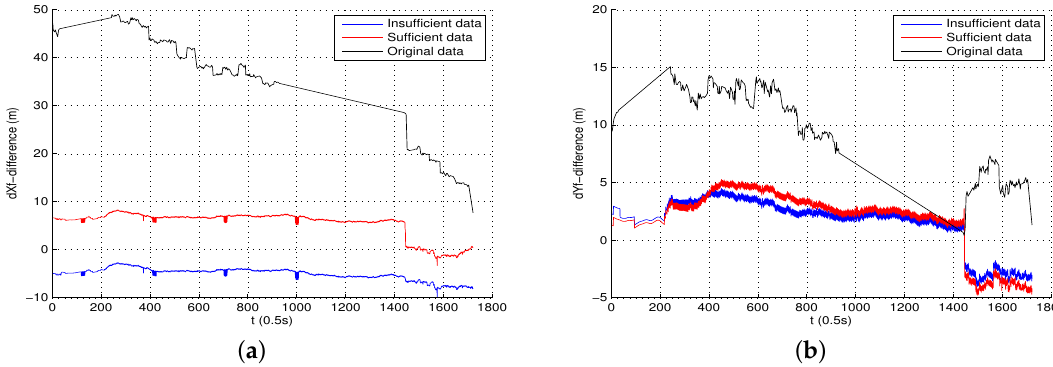
Figure 23. Deviation between estimated position and true position of M-DS recorded by IMU in AUV homing to the M-DS are illustrated by that in ( a ) X direction and ( b ) Y